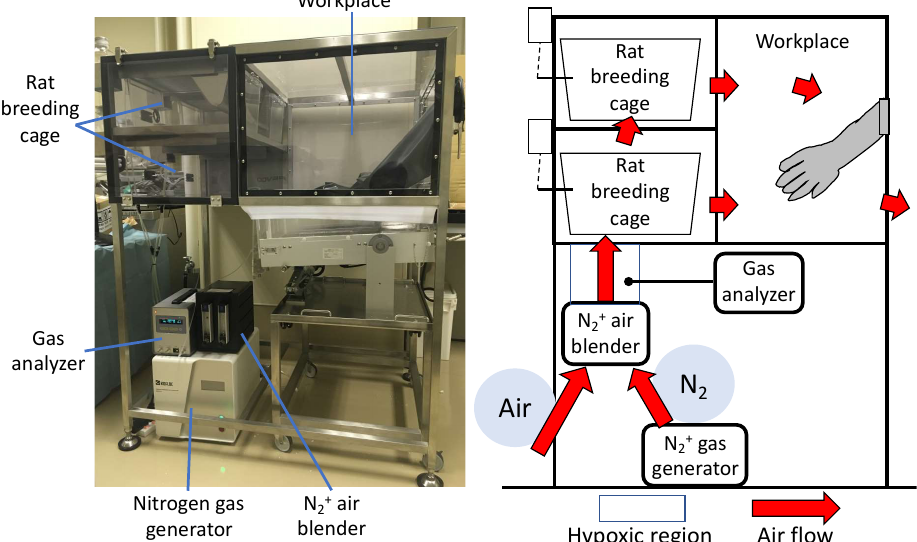
Figure 6. Hypoxic chamber. Nitrogen generated by the N 2 + gas generator is mixed with the outside air using a N 2 + air blender to generate hypoxia. The oxygen concentration in the chamber could be adjusted as desired by circulating low oxygen levels through the chamber.